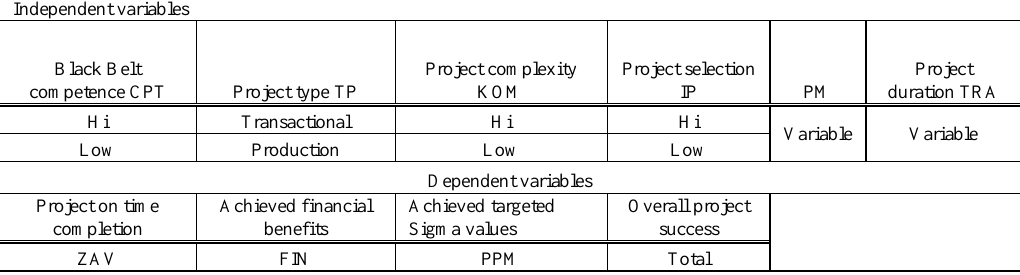
Table 3. Input output factors